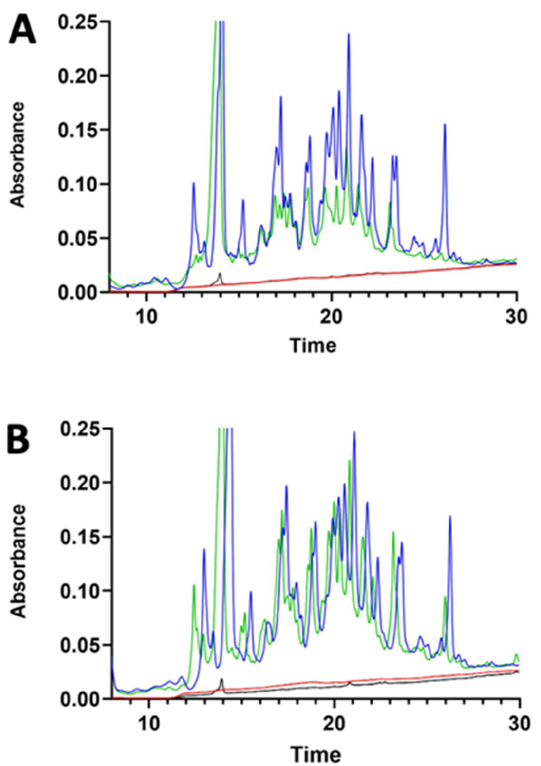
Figure 4. RP-HPLC chromatograms of the jejunum ( A ) and ileum ( B ) apical and basolateral sides of Ussing chamber at the beginning of the experiment (blue and red lines, respectively) and after 30 min of incubation with γ -C50 sample (green and black lines, respectively). γ -C50: 0.50 mg/mL of intact γ